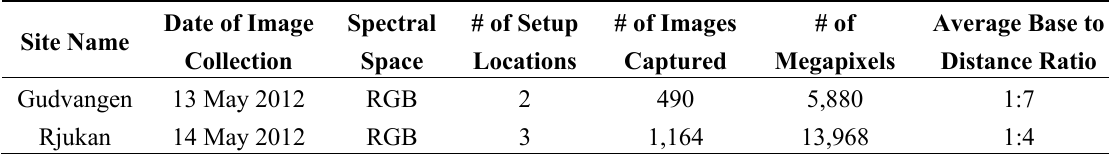
Table 1. Detailed breakdown of images collected at the Gudvangen and Rjukan sites in